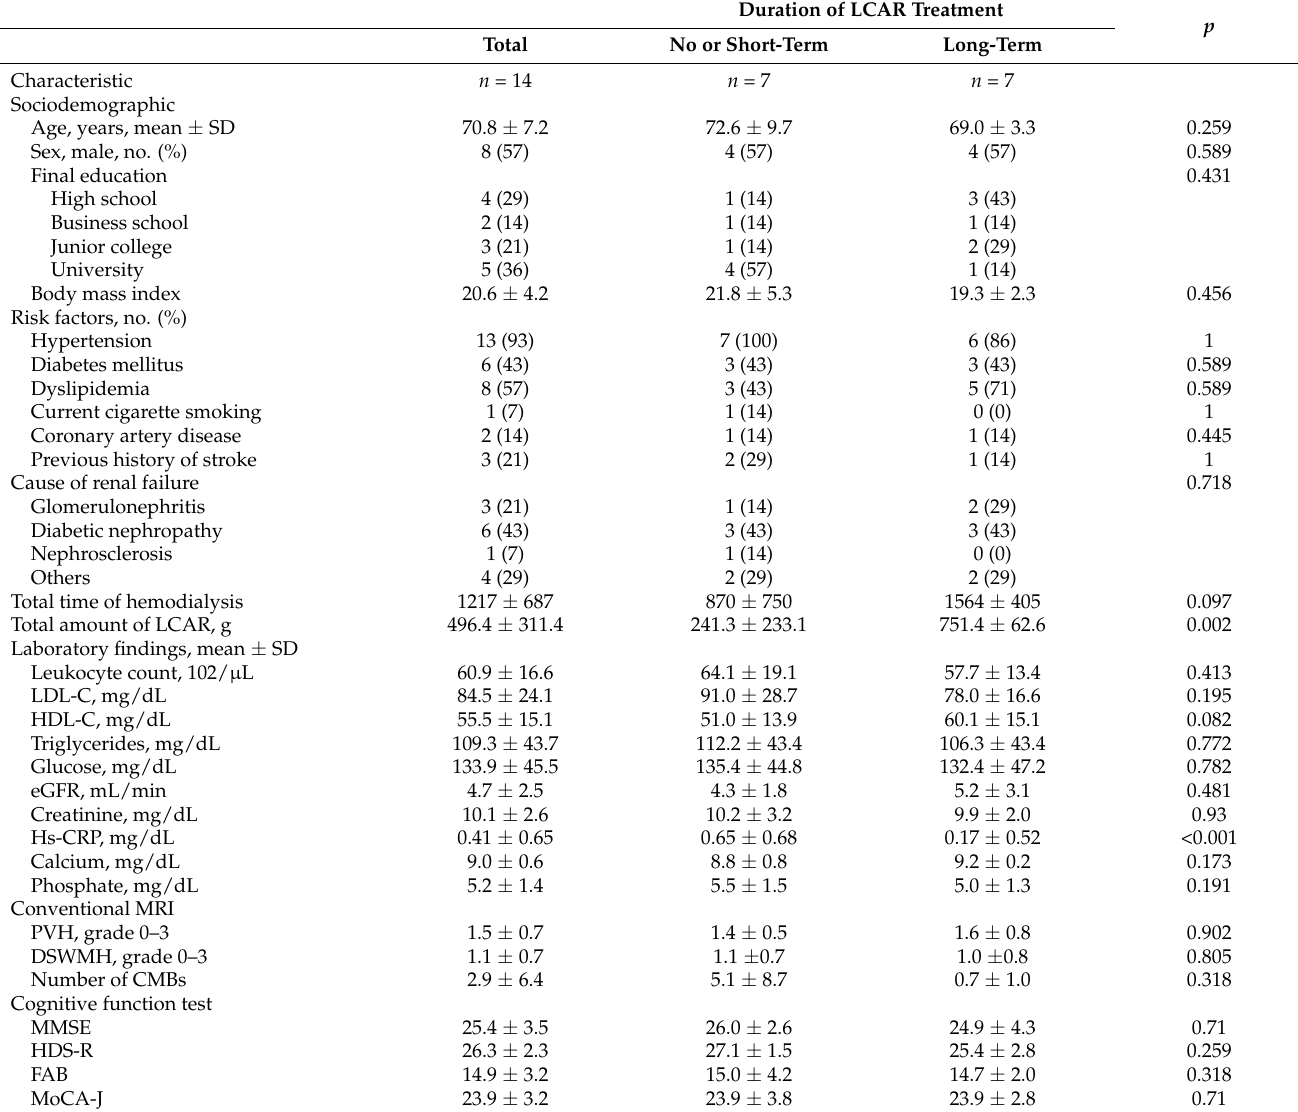
Table 1. Baseline characteristics, laboratory data, and cognitive and radiological findings according to total duration of L -carnitine treatment in hemodialysis